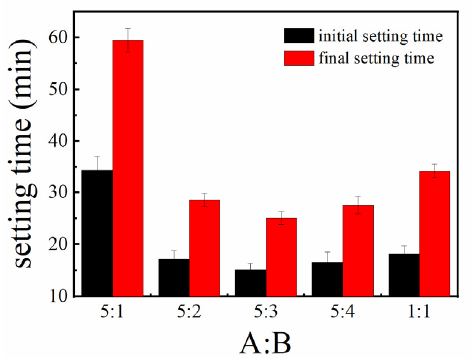
Figure 7. Effect of the ratio of A to B on the setting time of the